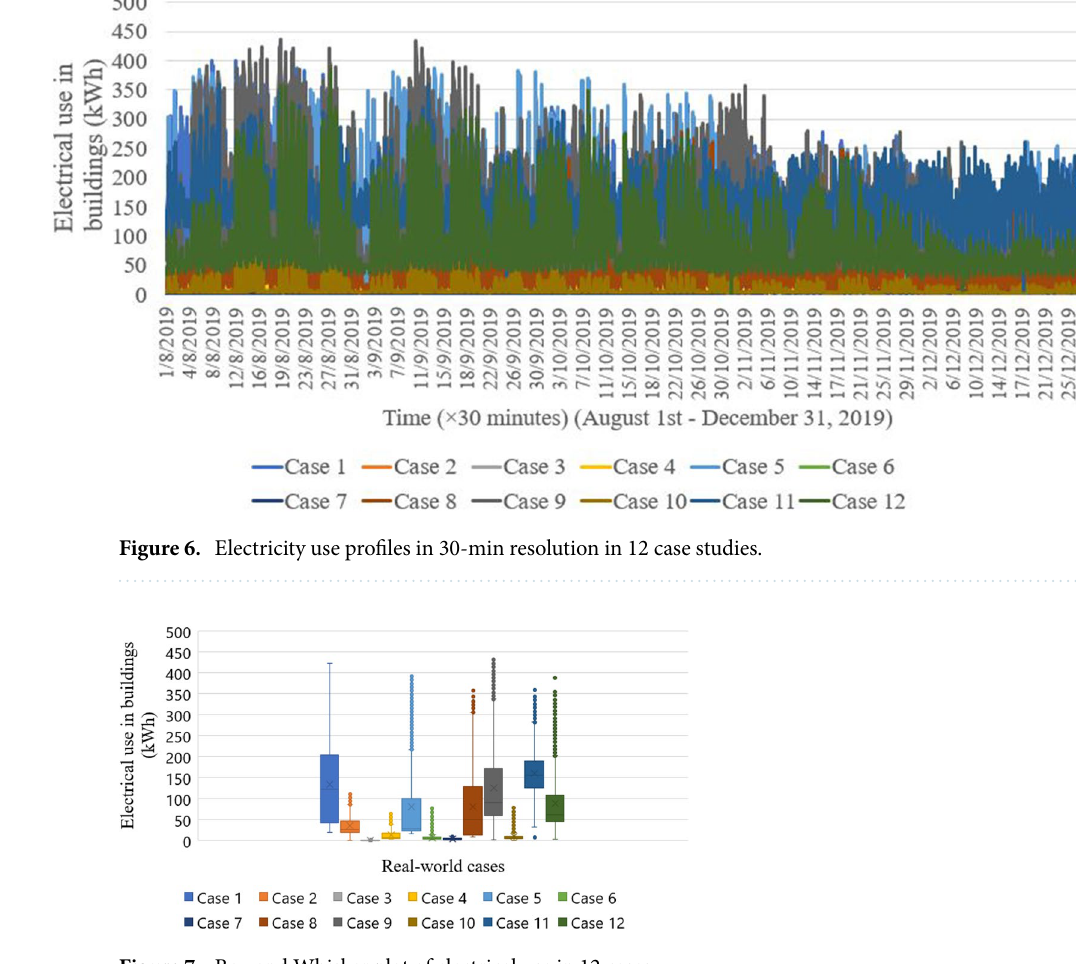
Figure 7. Box and Whisker plot of electrical use in 12